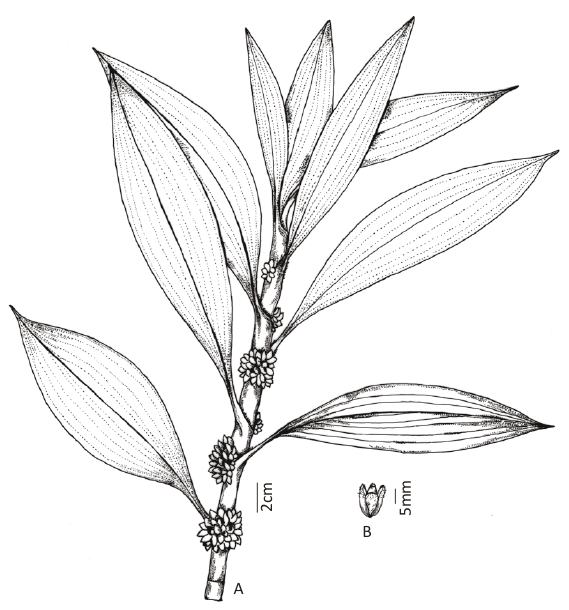
Figure 1. Amischotolype glabrata Hassk. (cid:4)(cid:3)(cid:882)(cid:3)(cid:38)(cid:396)(cid:437)(cid:349)(cid:415)(cid:374)(cid:336)(cid:3)(cid:410)(cid:449)(cid:349)(cid:336)(cid:854)(cid:3)(cid:17)(cid:3)(cid:882)(cid:3)(cid:18)(cid:258)(cid:393)(cid:400)(cid:437)(cid:367)(cid:286)(cid:3)(cid:896)(cid:282)(cid:396)(cid:258)(cid:449)(cid:374)(cid:3)(cid:296)(cid:396)(cid:381)(cid:373)(cid:3) M.D. Nandikar